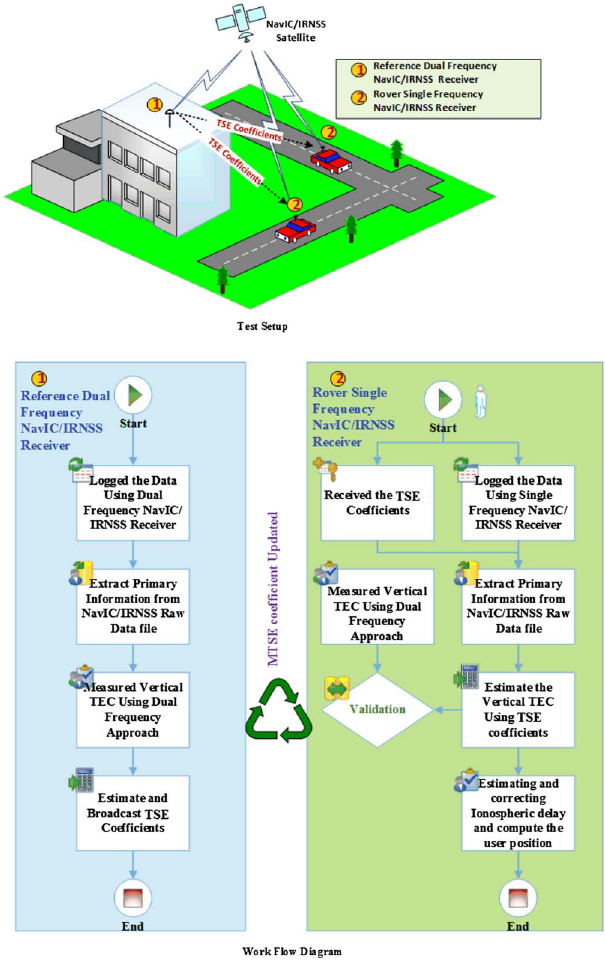
Fig. 2. Experimental setup and fl ow